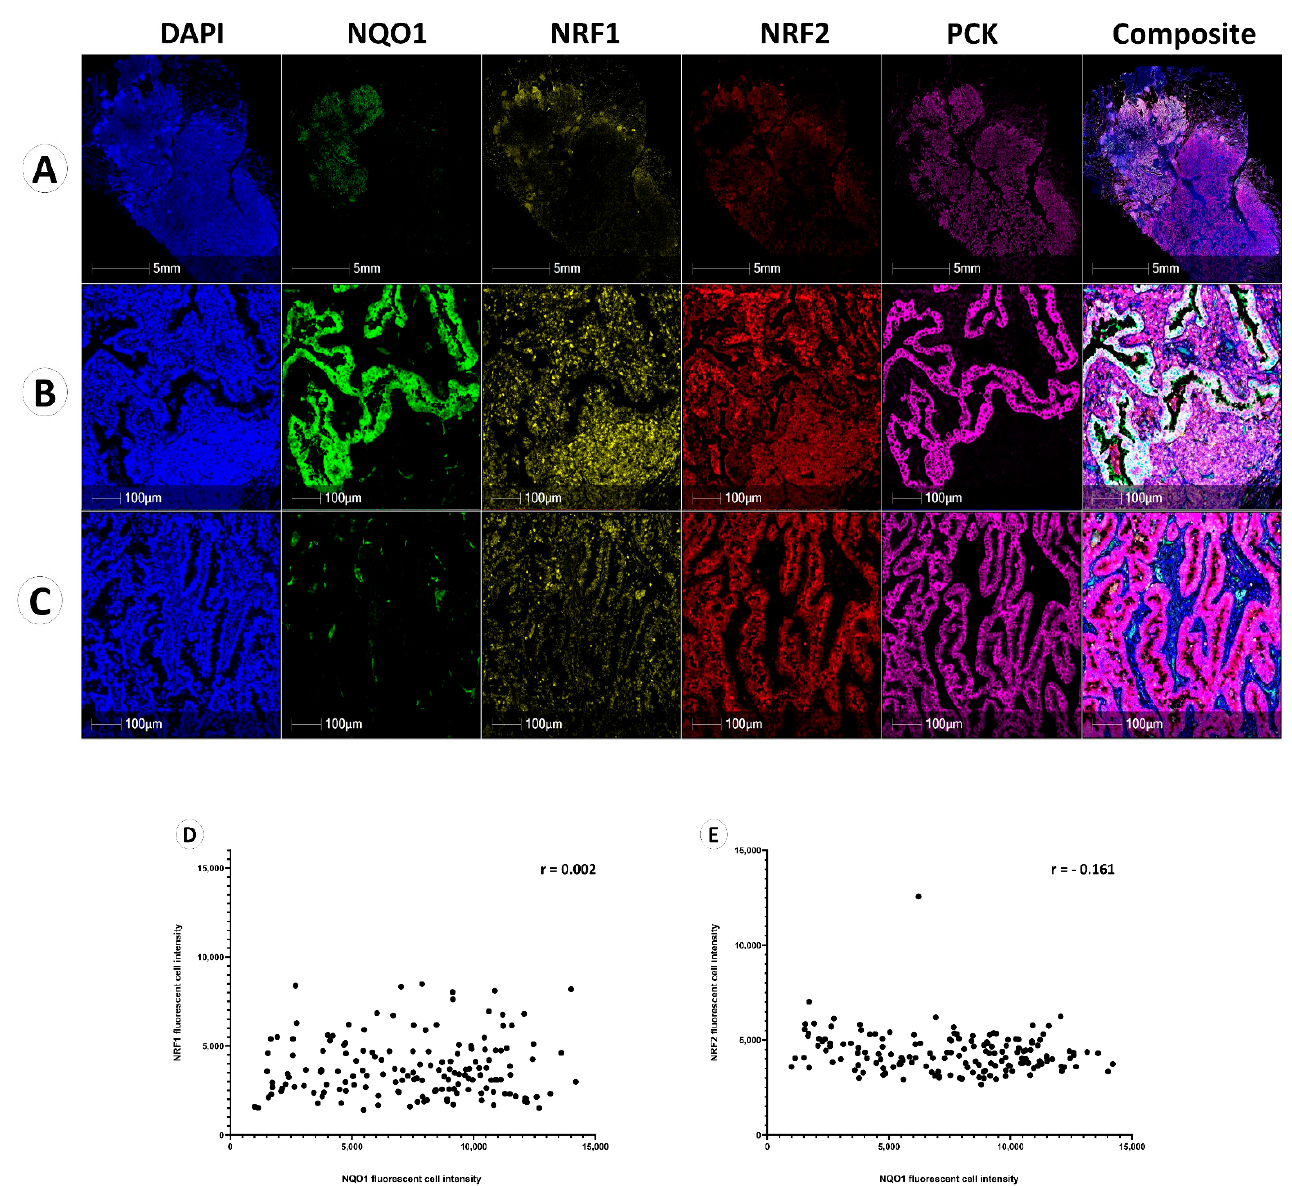
Figure 3. NQO1, NRF1 and NRF2 expression in NSCLC. Five fluorescent channels illustrating the expression of DAPI (blue), NQO1 (green), NRF1 (yellow), NRF2 (red), and pan-cytokeratin (pink), individually. ( A ) Whole slide image (WSI) of a case showing heterogeneous NQO1 expression. Composite images display all channels’ overlay. ( B ) NQO1 highly expressed region in WSI ( A ). ( C ) NQO1 lowly expressed region in WSI ( A ). ( D ) Spearman correlation between NRF1 fluorescent cell intensity and NQO1 fluorescent cell intensity in cancer cells (r = 0.002). ( E ) Spearman correlation between NRF2 fluorescent cell intensity and NQO1 fluorescent cell intensity in cancer cells (r = − 0.161).